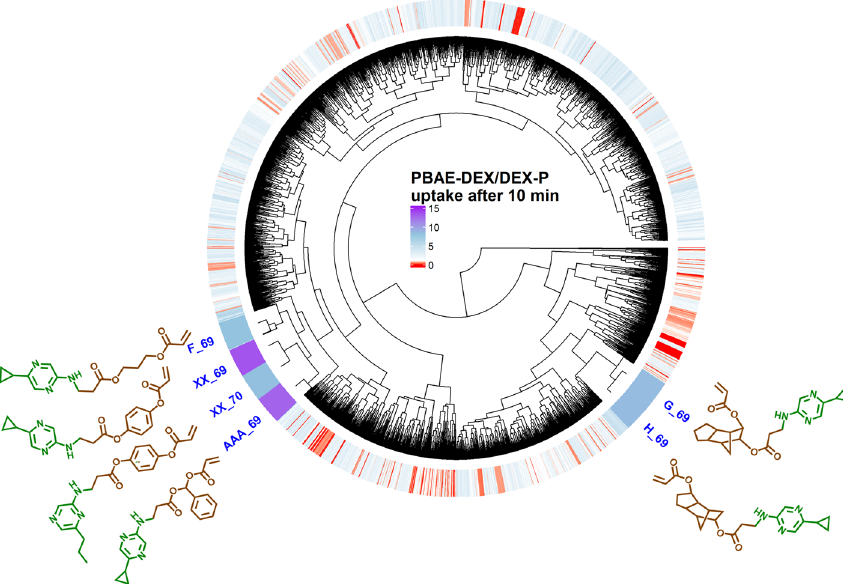
Figure 6. Heatmap of predicted ratio of DEX uptake for PBAE endcapped with e1 conjugated with DEX over commercial formulation of DEX after 10 min of exposure and structure of PBAE repeated unit with predicted drug uptake superior to experimental found candidate.